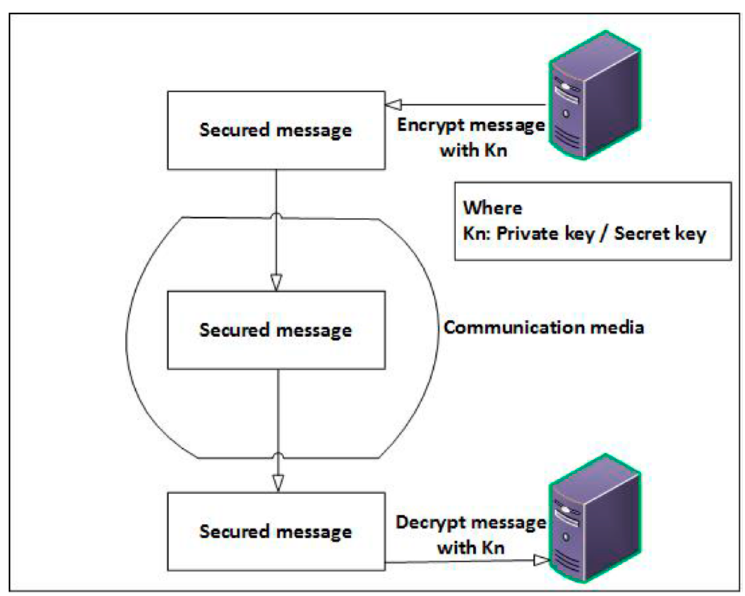
Figure 8. Symmetric cryptographic approach.